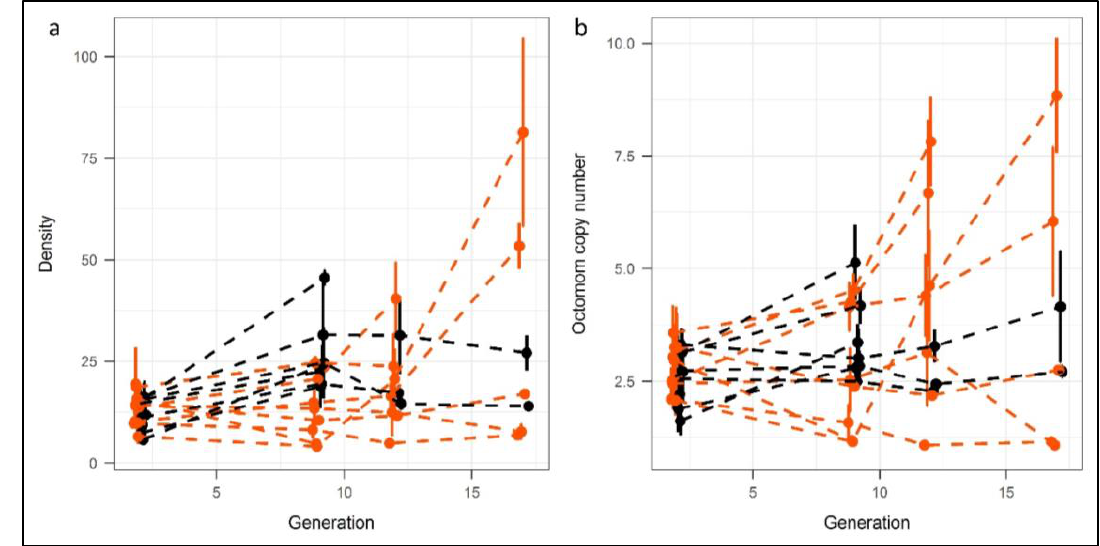
Figure 3. Evolution of Wolbachia density and octomom copy number. (a) Mean Wolbachia relative density (± standard error) in all lines in the paraquat (orange) and water (black) conditions, at generations 2, 9, 12 and 17. (b) Mean octomom copy number (± standard error) in all lines in the paraquat (orange) and control (black) conditions, at generations 2, 9, 12 and